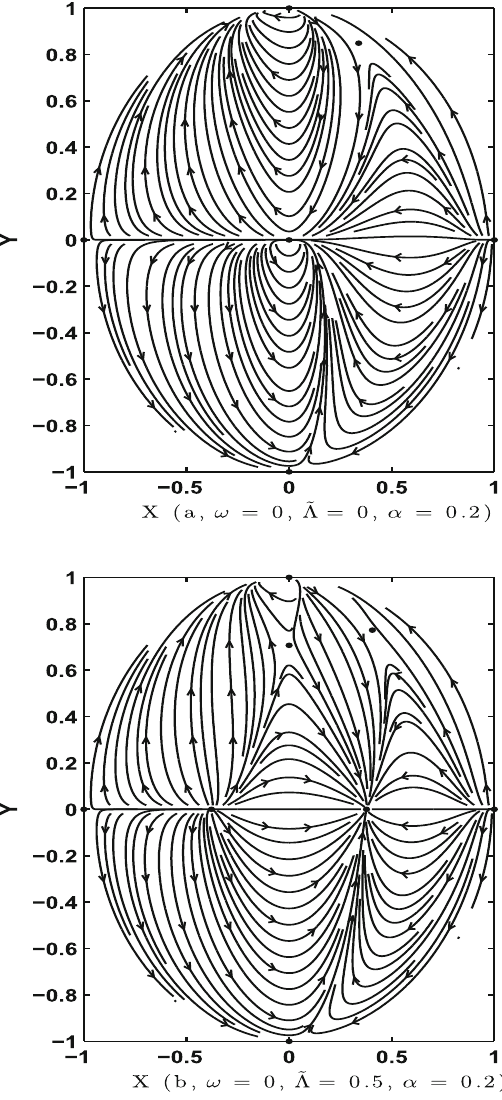
Fig. 19 Uncompact (left panel) and compact (right panel) phase por- traits when variable viscosity coefficients, is included, ˜ ξ = α x 2 , (α = 0 . 2 ) for dust case (ω = 0 ) but ˜ (cid:4) = ( 0 , 0 . 5 ), . x 1 and x 2 respectively